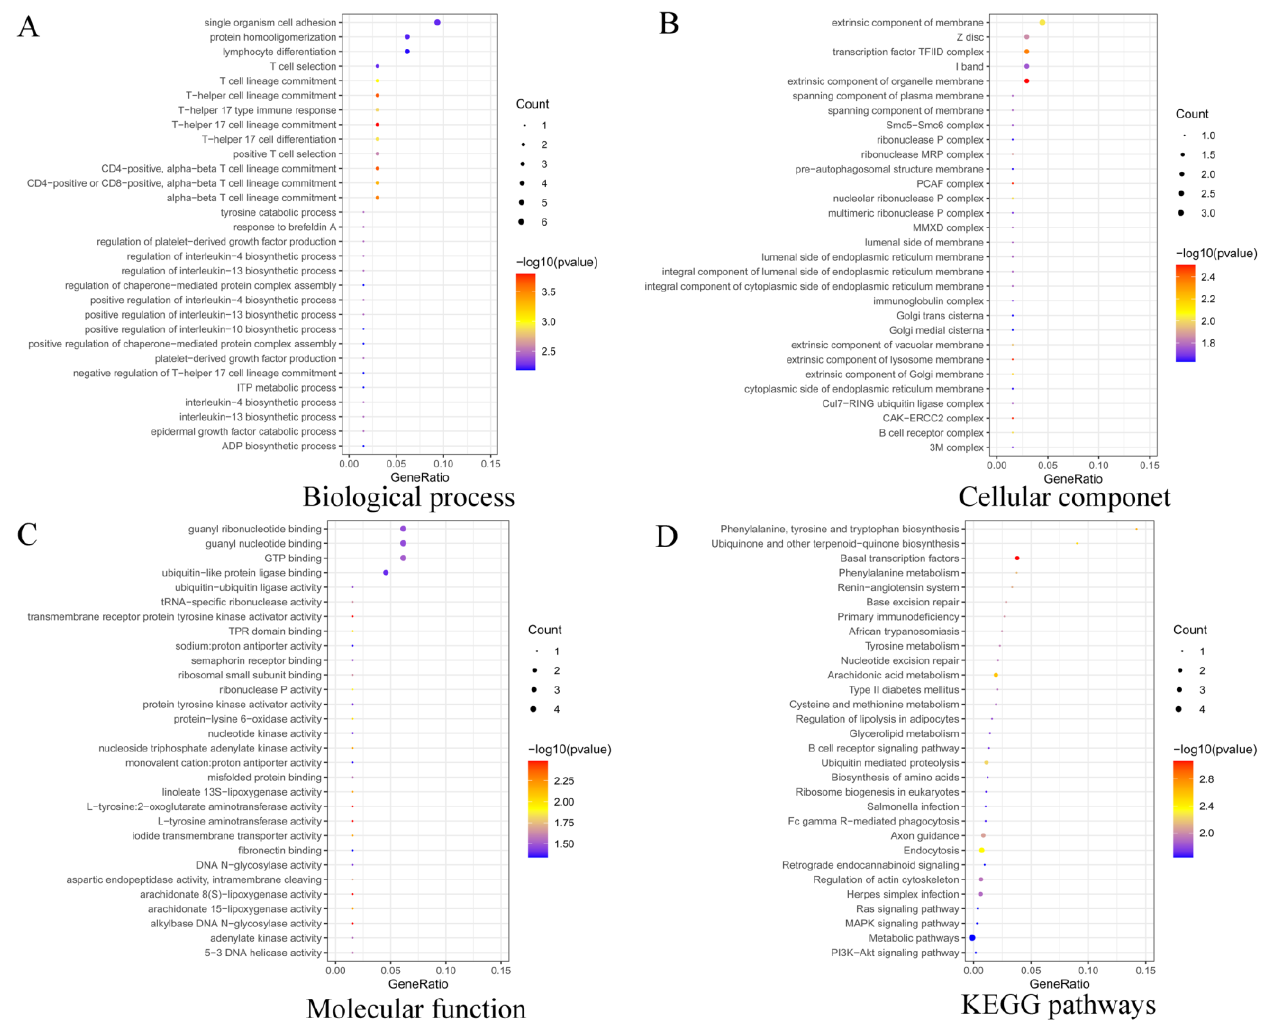
Figure 5. GO and KEGG functional enrichment analysis of target genes. ( A ) Top 30 GO term with biological process in SM vs. ST. ( B ) Top 30 GO term with cellular component in SM vs. ST. ( C ) Top 30 GO term with molecular function in SM vs. ST. ( D ) Top 30 KEGG pathways in SM vs. ST.